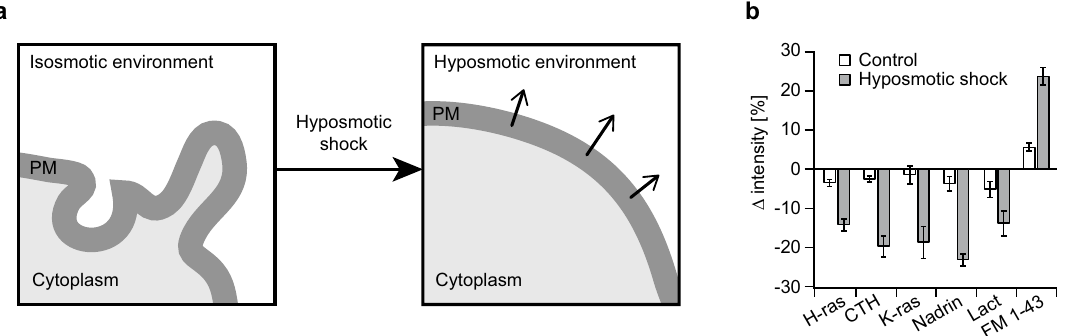
Figure 4. H-ras, CTH, and K-ras are released from PM after hyposmotic shock. NIH 3T3 expressing GFP- H-ras G12V (H-ras), CFP-CTH (CTH), GFP-K-ras G12V (K-ras), Lact-GFP (Lact) and Nadrin-YFP (Nadrin N-BAR), or stained with plasma membrane dye FM1-43 were subjected to hyposmotic shock. ( a ) A scheme illustrating impact of hyposmotic shock on PM membrane curvature. ( b ) Plot summarizes changes in normalized integrated membrane intensity of fusion proteins caused by hypoosmotic shock. The difference is calculated as % change in intensity between a mean value of 3 images taken within the first 60 s of imaging (i.e. before hyposmotic shock) and mean value of 4 images taken at the end of